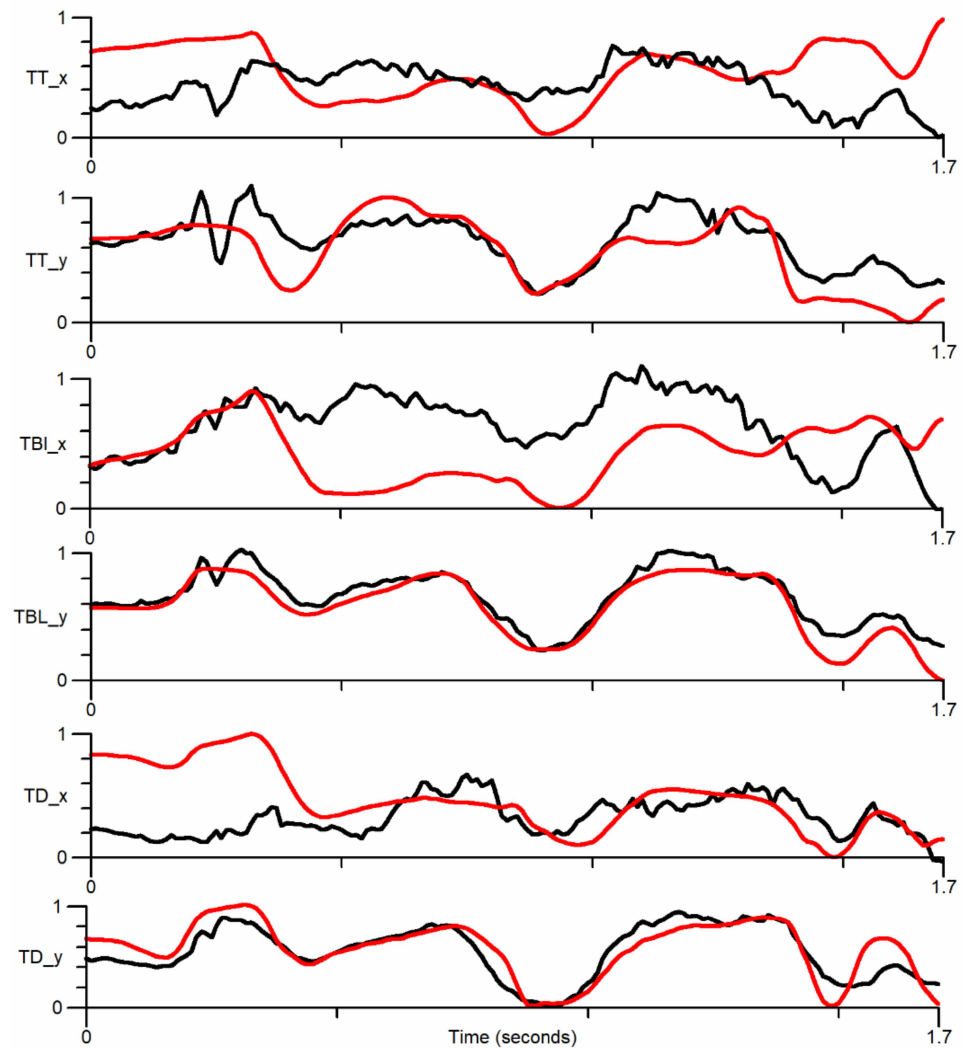
Figure 14. The phrase ‘She said “bead” clearly’ showing x and y position against time for the tongue tip (TT), blade (TBl), and dorsum TD. Red—EMA sensor; black—DLC estimated position. The y -axis has no units.